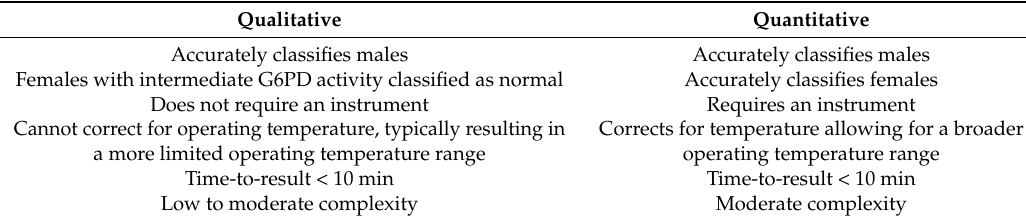
Table 2. Characteristics of qualitative and quantitative point-of-care G6PD